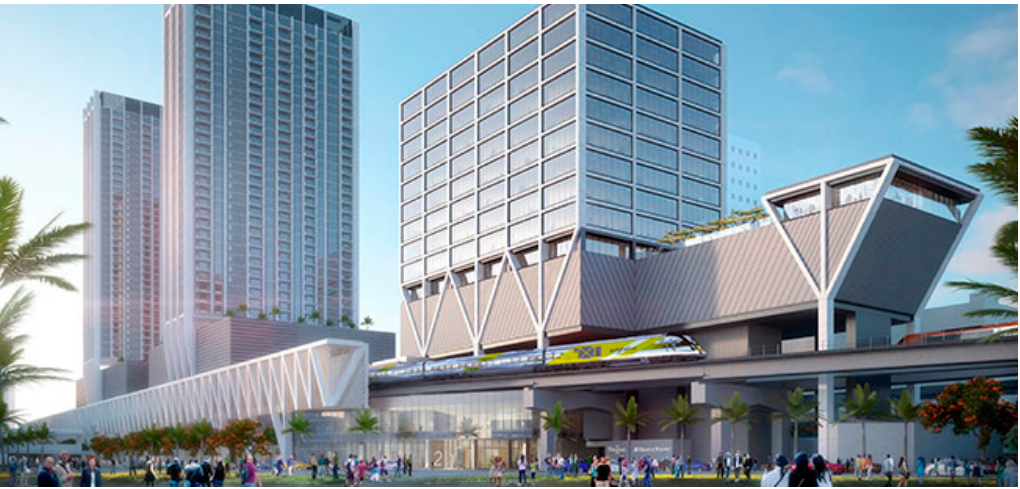
Figure 1. Miami Brightline. Source: All Aboard Florida, Brightline.